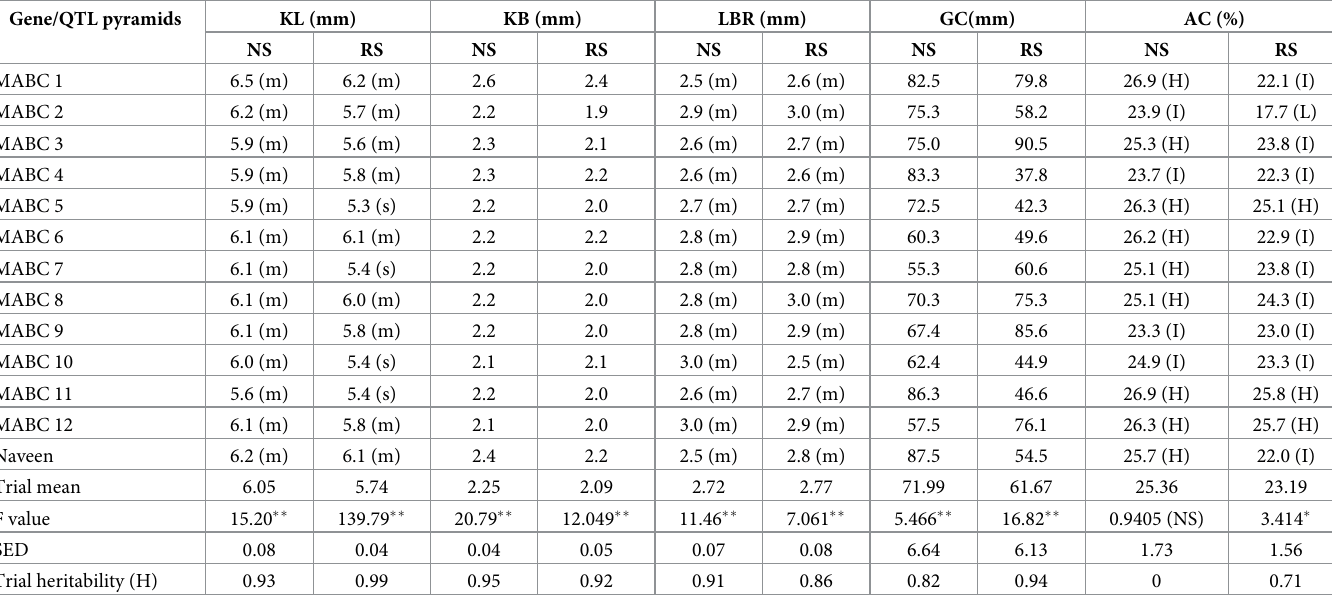
Table 6. Grain quality characteristics of MABC lines under control and drought conditions during WS2018. Gene/QTL